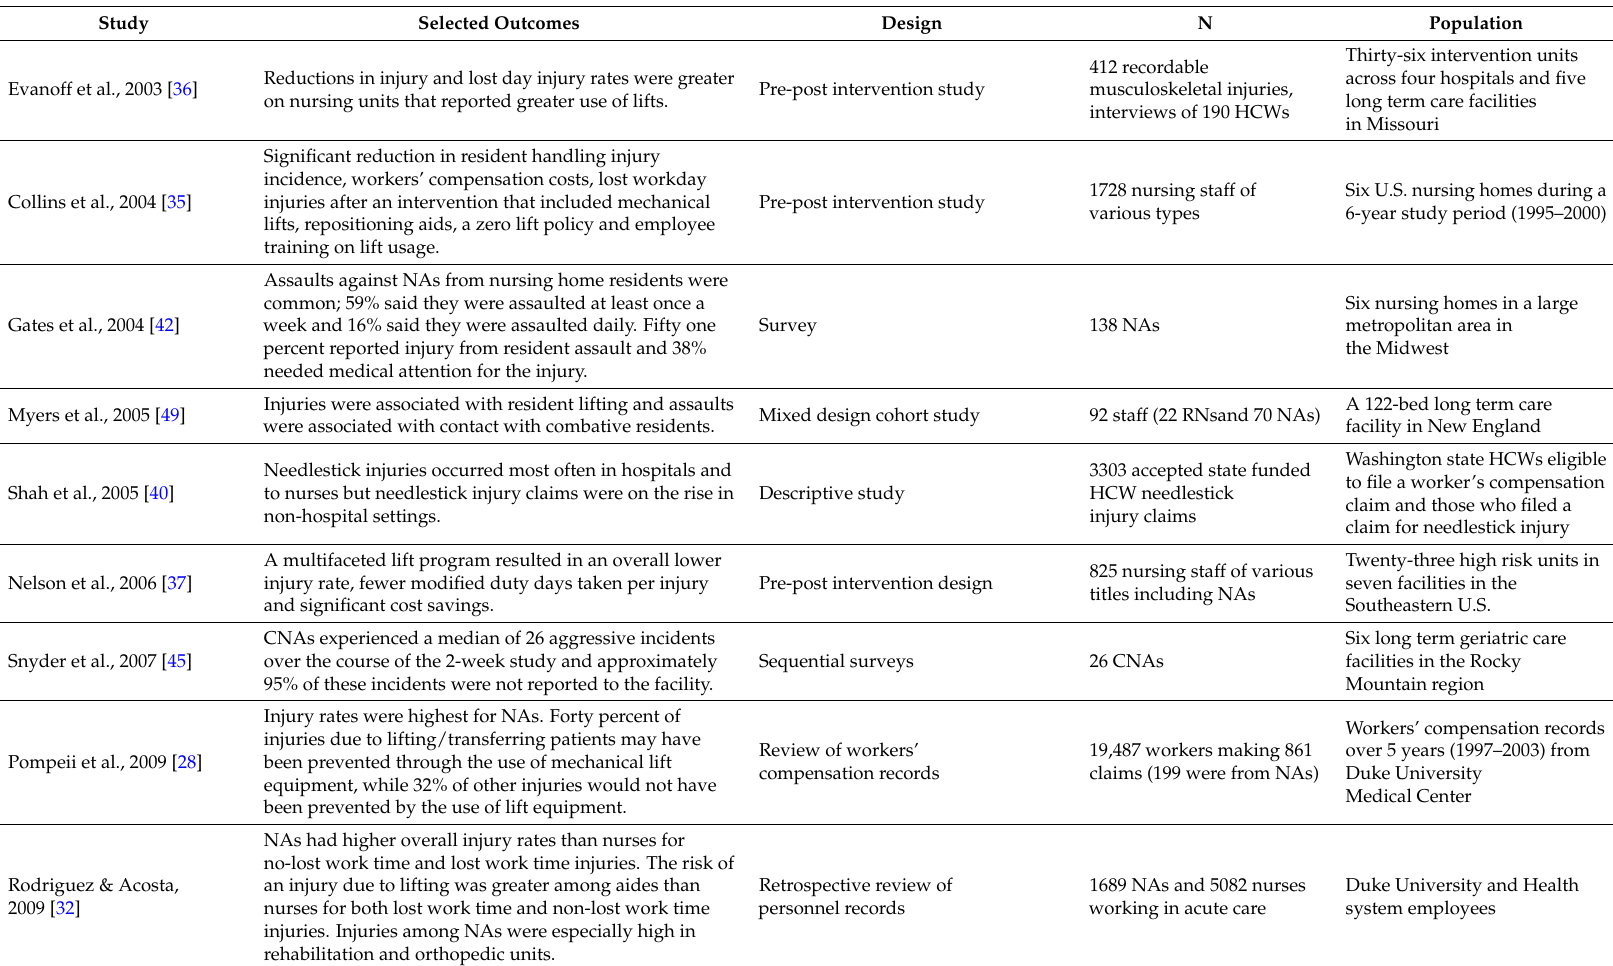
Table 3. Summary of literature reviewed for occupational health and safety hazards to nursing assistants—enviromechanical hazards.